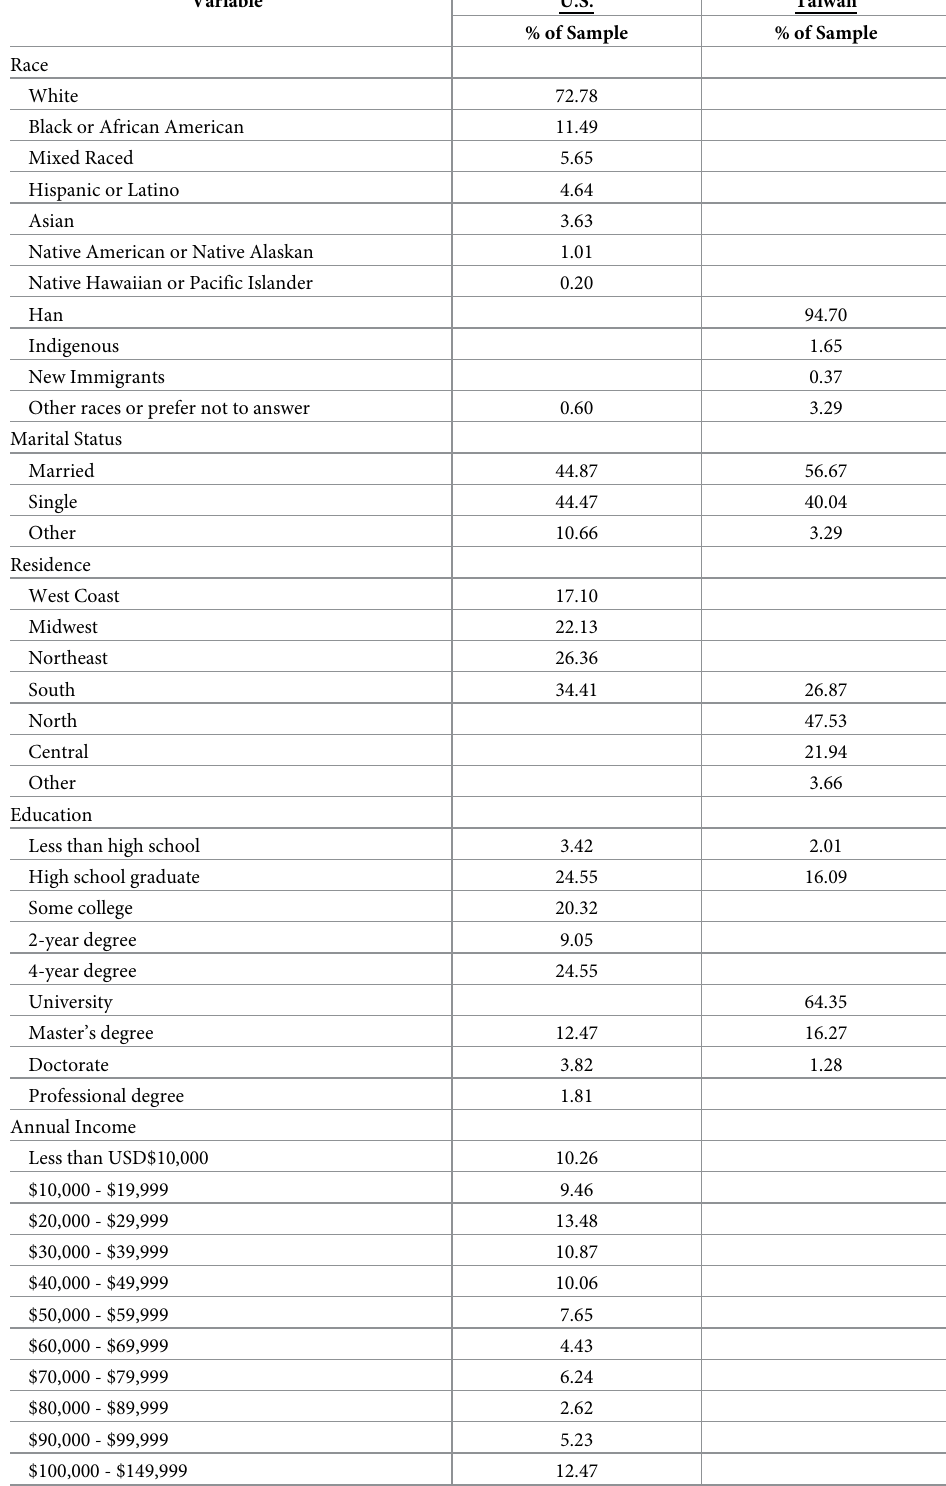
Table 1. Demographic characteristics of American and Taiwanese